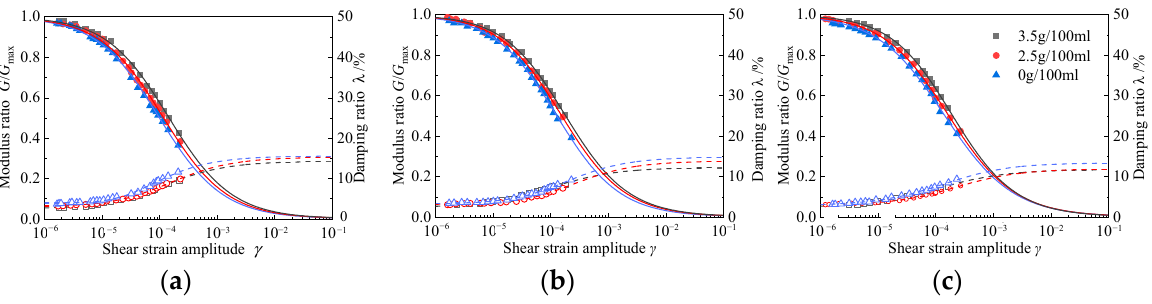
Figure 26. The G/G max ~ γ and λ ~ γ curves of the RCS soil with different cement contents. (a) σ ' m = 50 kPa, X = 20%, ( b ), σ ' m = 100 kPa, X = 20%, ( c ) σ ' m = 150 kPa, X = 20%. X = 20%, ( b ), σ (cid:48) m = 100 kPa, X = 20%, ( c ) σ (cid:48) m = 150 kPa, X =